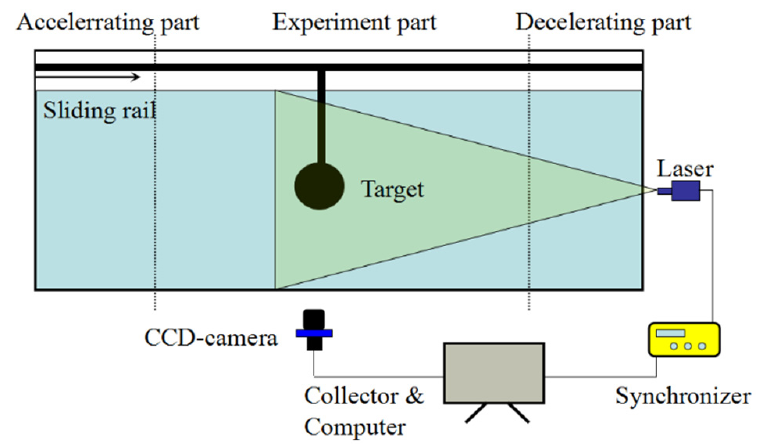
Figure 4. Schematic diagram of the experimental facility. The two-dimension PIV system was provided by TSI. The model of the layer was YAG200-NWL, with maximum output energy of 200 mJ, and its pulse width was 3–5 ns. The 4MX-CCD camera was used to capture the image of the flow field at 2048 × 2048 pixels. The minimum span frame time of the CCD camera was 200 ns, and its frame rate was 15 frames per second. In this experiment, images were collected in double-frame and double-exposure mode and processed by the mutual algorithm of the system. Some key parameters used in the experiment are shown in Table 1. Table 1. Some key parameters used in the PIV